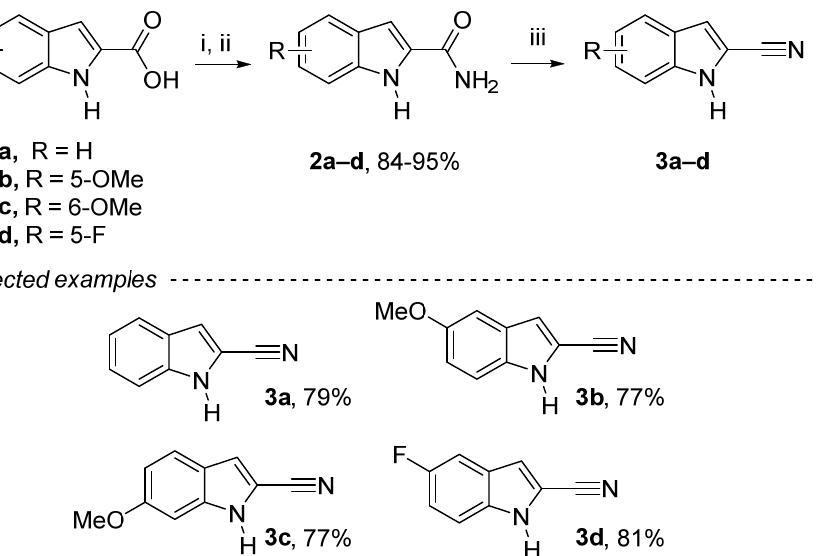
Figure 1. Biologically relevant compounds, featuring 2-cyanoindole